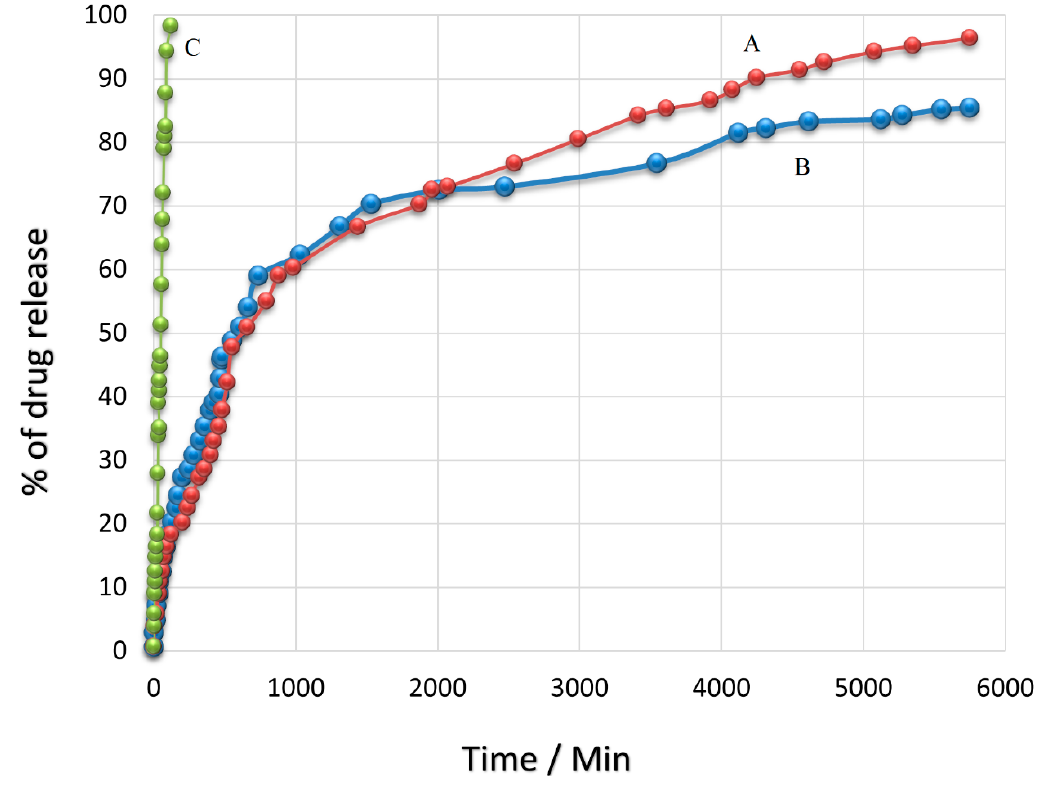
Figure 7. Sorafenib drug release from Fe 3 O 4 @PEG_SFB into PBS at (A) pH 4.8; (B) pH 7.4 and (C) free sorafenib.